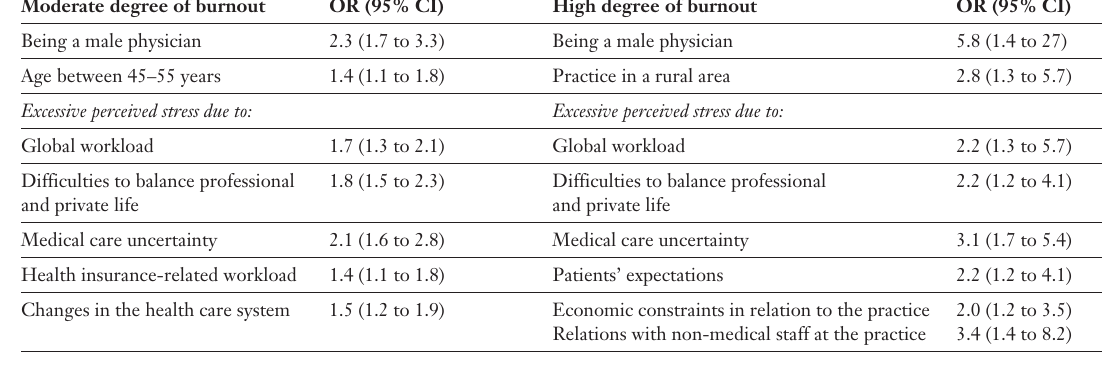
Table 4 Distribution of the three subscale scores of the Maslach Burnout Inventory burnout among medical doctors in different Western